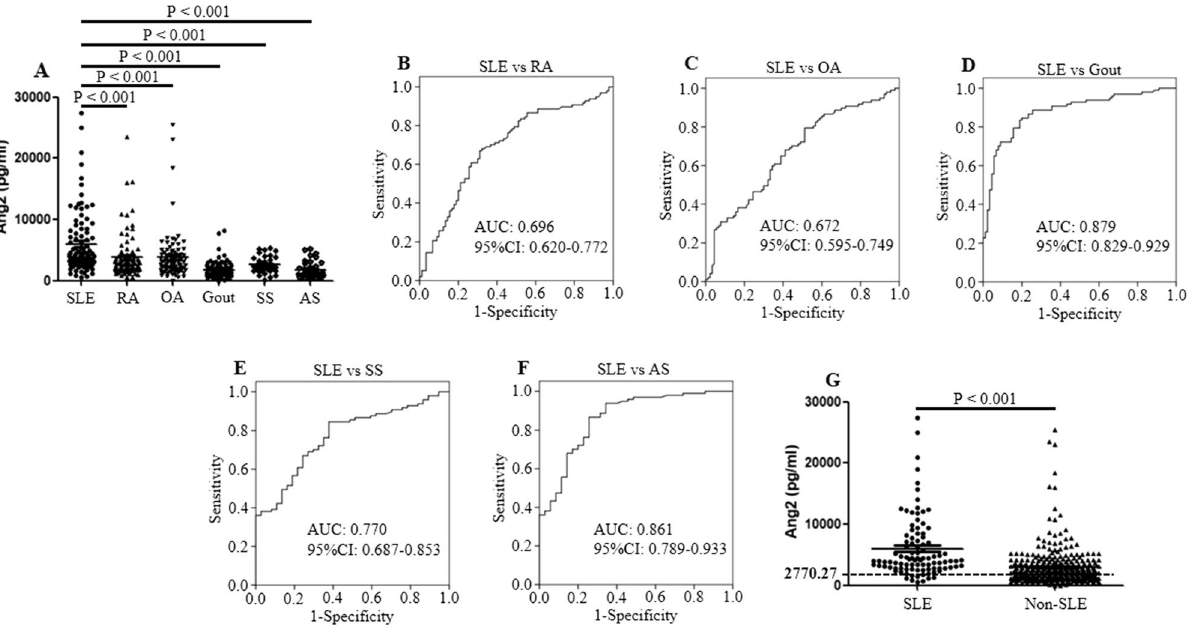
Figure 2. Ang2 expression in SLE patients from validation cohort. ( A ) Serum Ang2 levels in the validation cohort. Serum Ang2 protein concentrations were compared between patients with SLE (n = 97) and those with other inflammatory autoimmune diseases (n = 342, including 90 RA, 90 OA, 90 gout, 37 SS, 35 AS patients). The Ang2 levels were examined by enzyme-linked immunosorbent assay. ( B – F ) Receiver operating characteristic (ROC) analysis was performed to evaluate the potential of Ang2 to differentiate SLE from other inflammatory autoimmune diseases. ( G ) Analysis of the difference in serum Ang2 between SLE and non-SLE patients. The black horizontal dotted line represents the cutoff value of 2770.27 pg/ml. SLE, systemic lupus erythematosus; RA, rheumatoid arthritis; OA, osteoarthritis; SS, Sjogren’s syndrome; AS, ankylosing spondylitis.